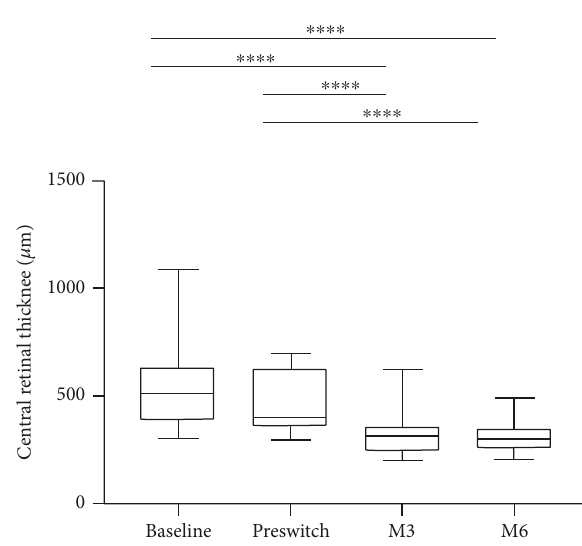
Figure 2: Change in central retinal thickness over 6 months of follow-up after switch to a fl ibercept. Box plots representing at each time point the distribution of data from bottom to top: minimum, fi rst quartile, median, third quartile, and maximum. p values were obtained after a paired parametric t -test after veri fi cation of the normal distribution. ∗∗∗∗ < 0.0001.